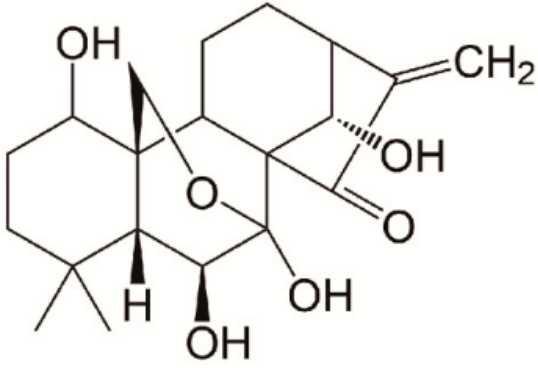
Figure 1. Chemical structure of oridonin.